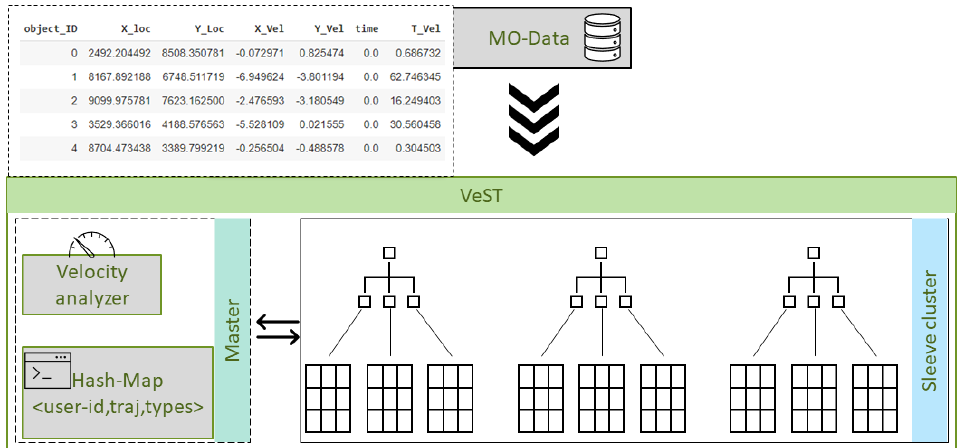
Figure 2. Architecture of velocity spatiotemporal index for moving